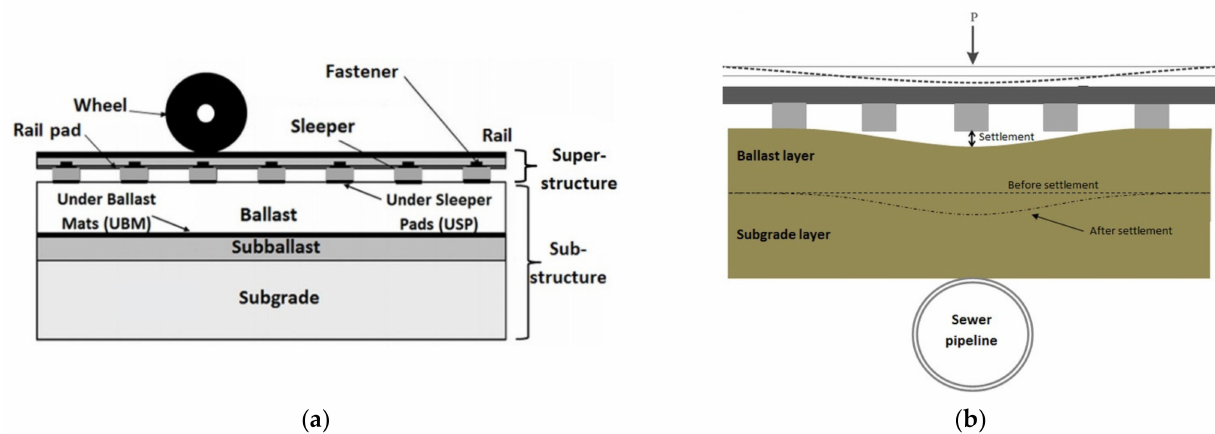
Figure 1. Two-dimensional (2D) longitudinal section of ballasted track: ( a ) track structure; ( b ) effect of pipe